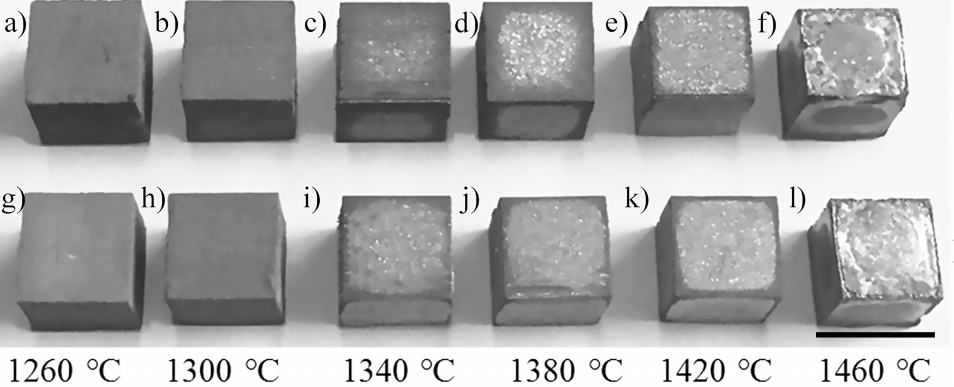
Figure 6. The appearance morphology of sintered samples with pure powder ( a – f ) and mixed powder ( g – l ) at di ff erent sintering temperatures. Scale bar = 1